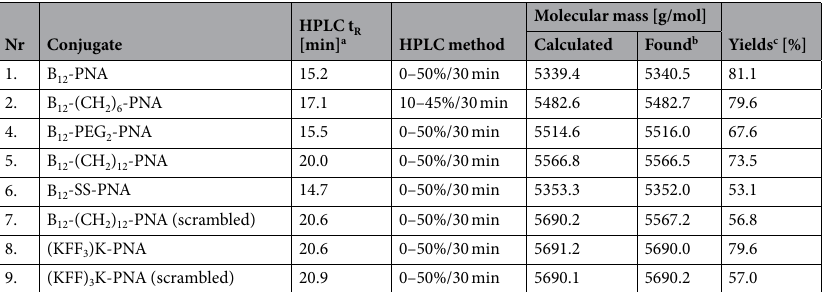
Table 1. Retention times (t R ) and molecular masses of the synthesized conjugates. a The product was analyzed by analytical RP-HPLC; b data obtained from Q-TOF Premier c isolated yield on 1 µ mol